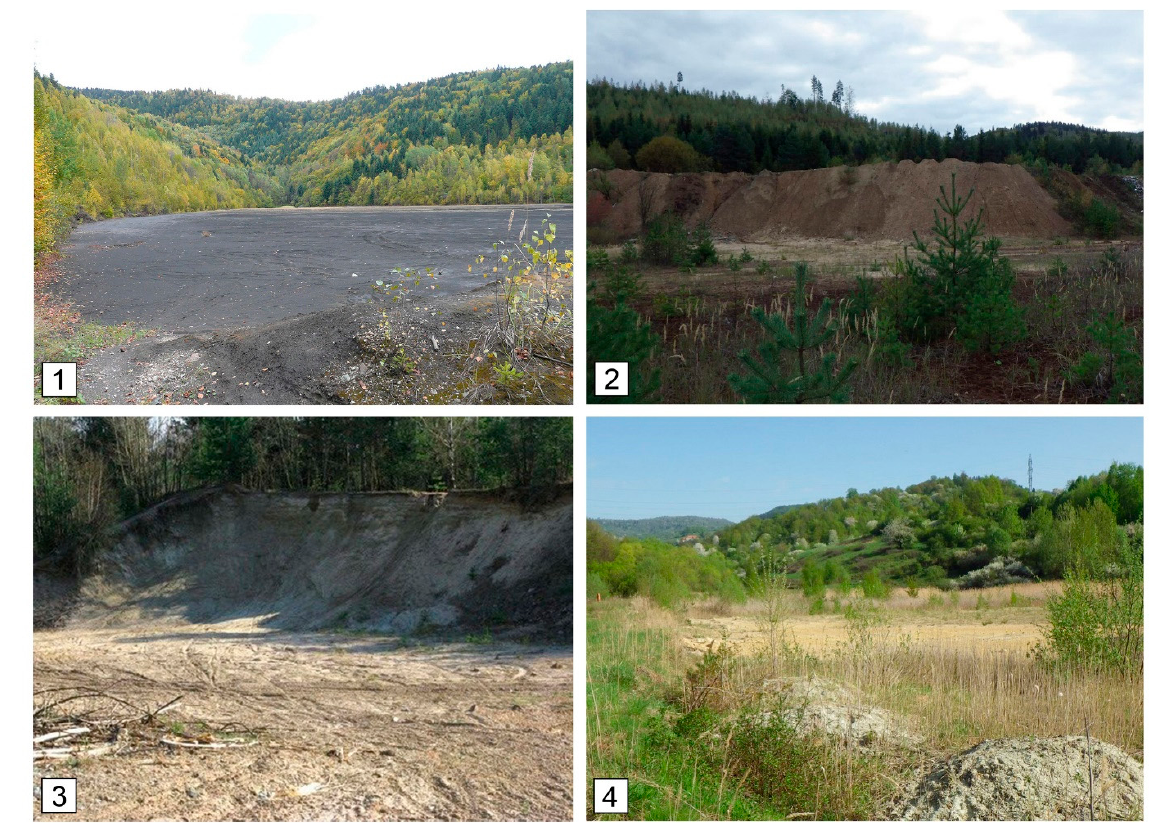
Figure 2. Images show the restored tailings ponds: 1—Slovinky (SLS, SLD), 2—Markušovce (MAS, MAD), 3—Lintich (LIS, LID), 4—Horná Ves (HVS, HVD). SLS—Slovinky slag; SLD—Slovinky dam; MAS—Markušovce sludge; MAD—Markušovce dam; LIS—Lintich sludge; SLD—Linitch dam; HVS—Horná Ves sludge; HVD—Horná Ves dam.